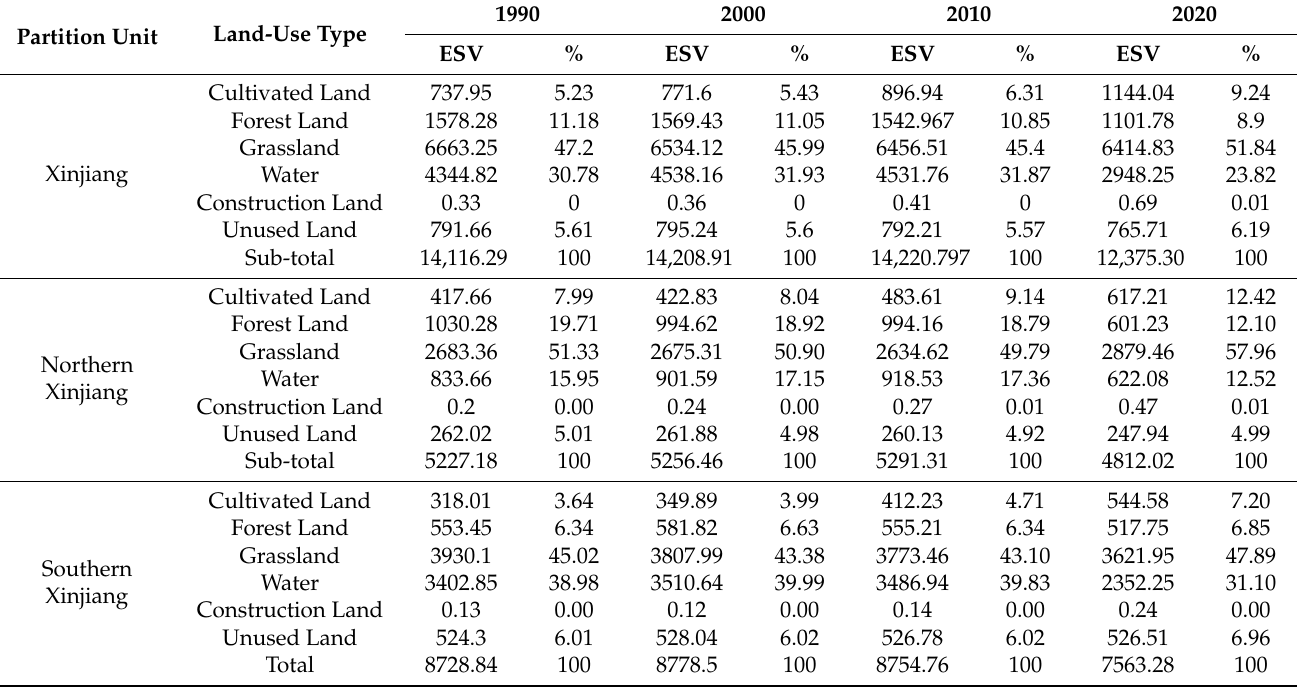
Table 4. Changes in the ESV of various land-use types in Xinjiang from 1990 to 2020 (10 8 yuan).